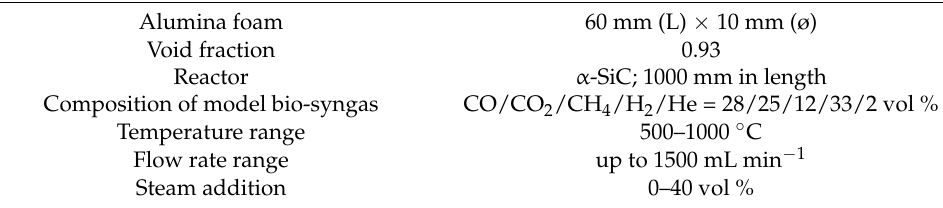
Table 1. Materials and reaction